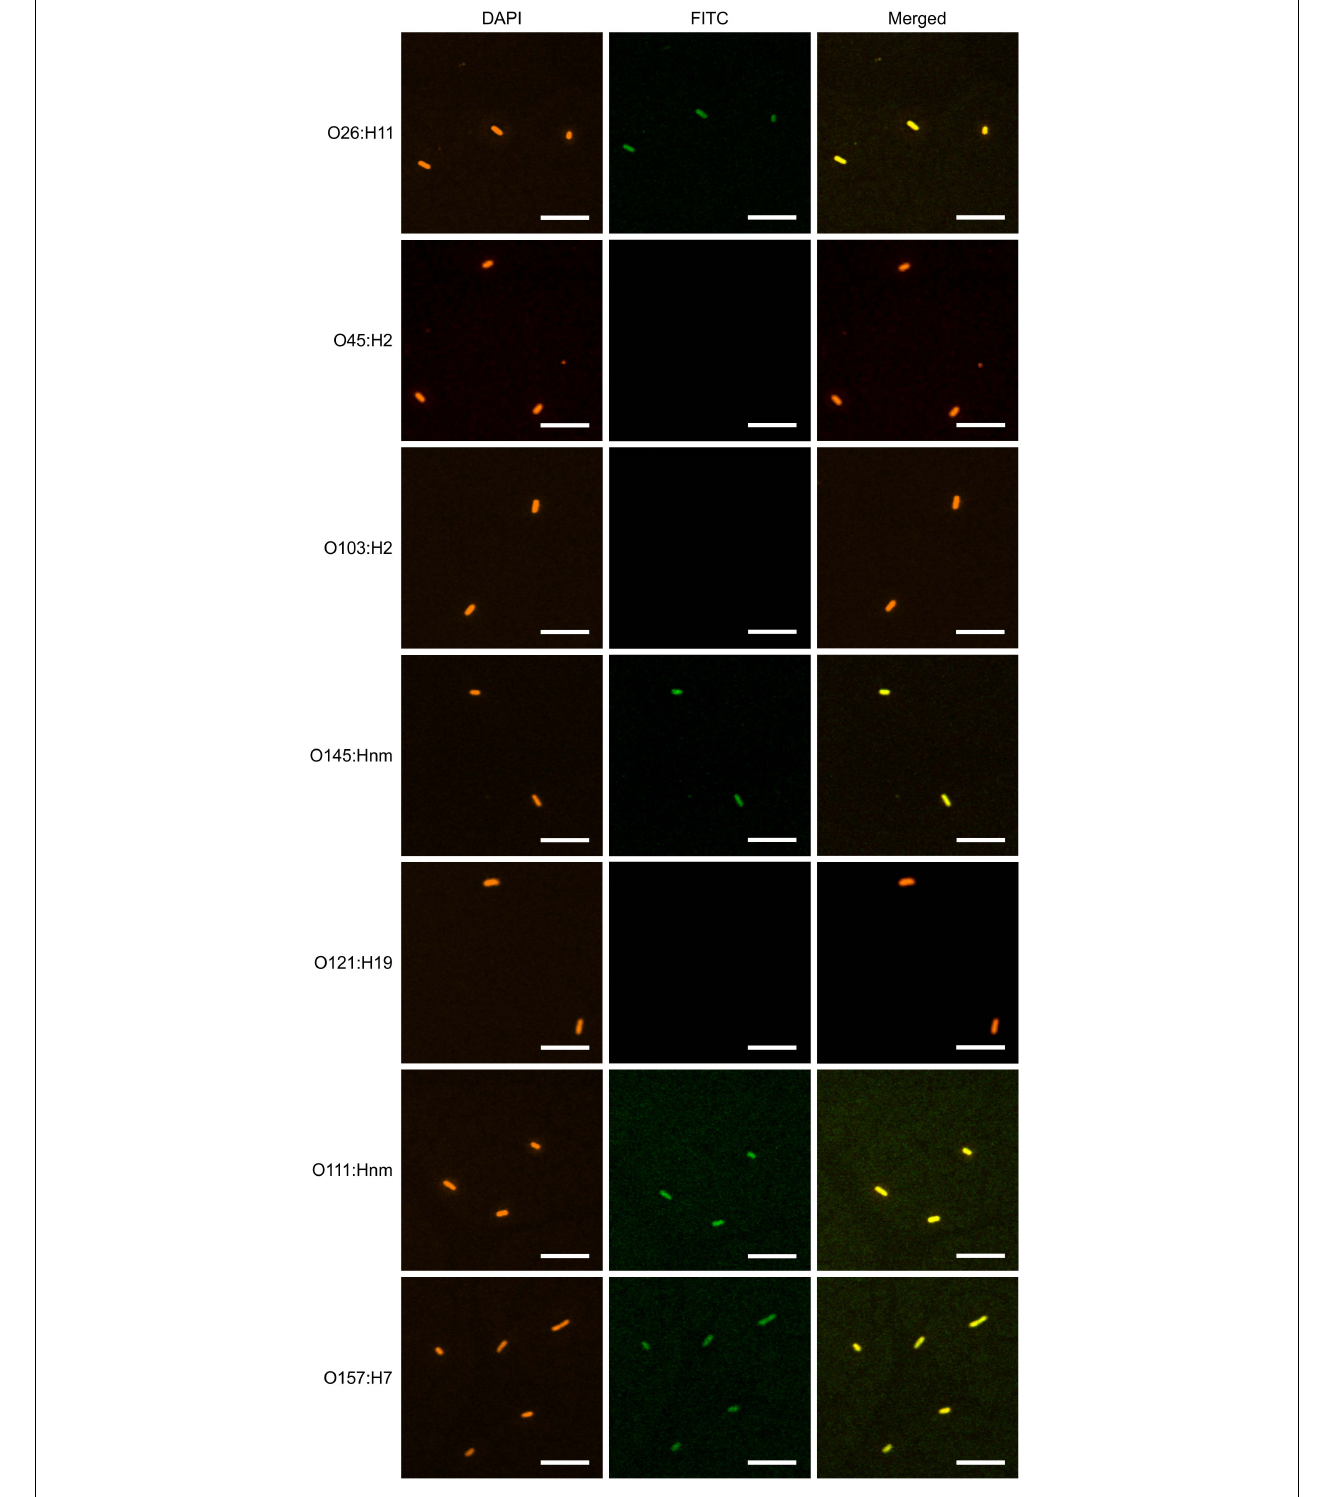
FIGURE 7 | V H H10-sIgA binds EHEC O145:Hnm, O26:H11, O111:Hnm, and O157:H7. Shown are confocal images visualizing the binding of the seven most prevalent strains of EHEC with V H H10-sIgA. Binding is visualized by DAPI that stains EHEC bacterial cells (blue) and a FITC-conjugated antibody that hybridizes to the Fc chain of V H H10-sIgA (green). A merged image shows an overlay of the blue and green channels used to visualize DAPI and FITC, respectively, to assess co-localization.